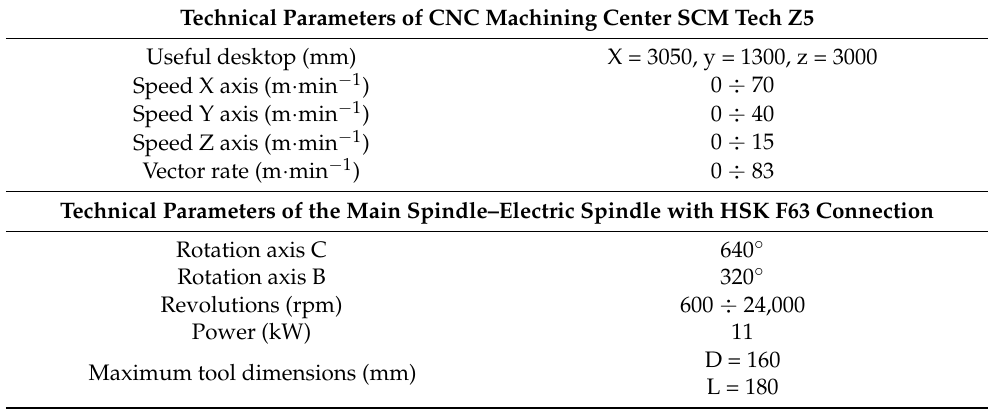
Figure 1. CNC machining center SCM Tech Z5. Table 1. Technical parameters of CNC machining center SCM Tech Z5.